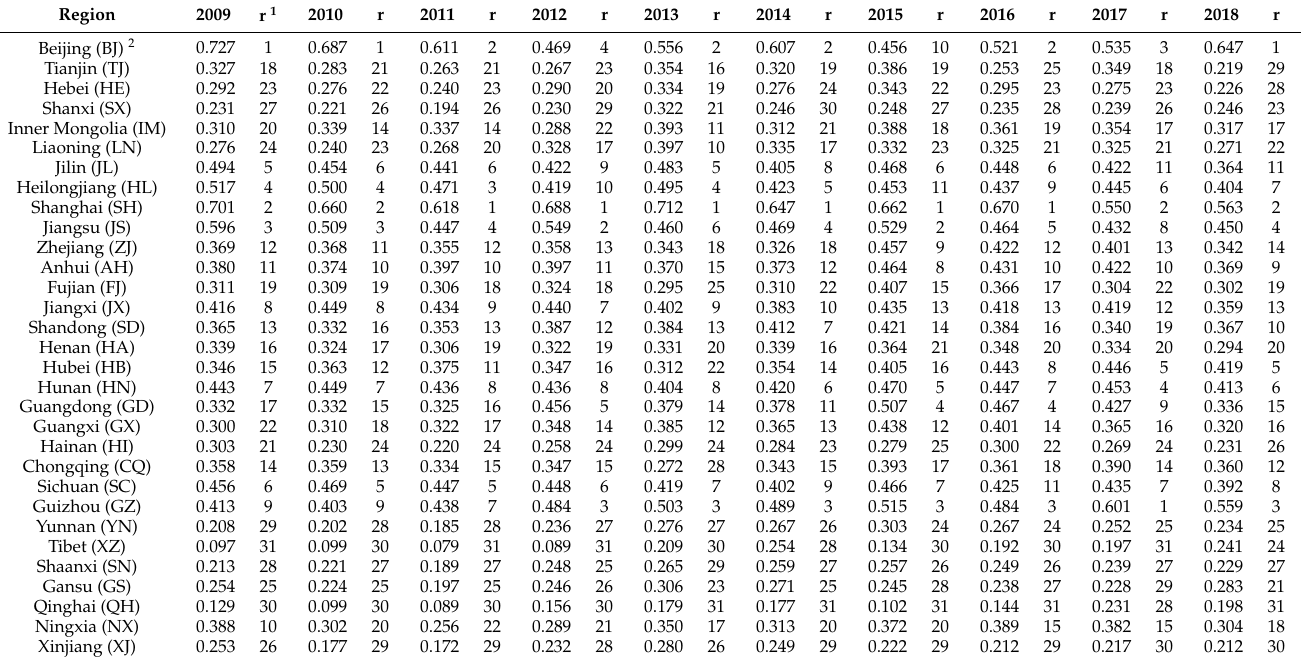
Table 5. Appraisement value of ecological development level of the forestry industry in each province. Region